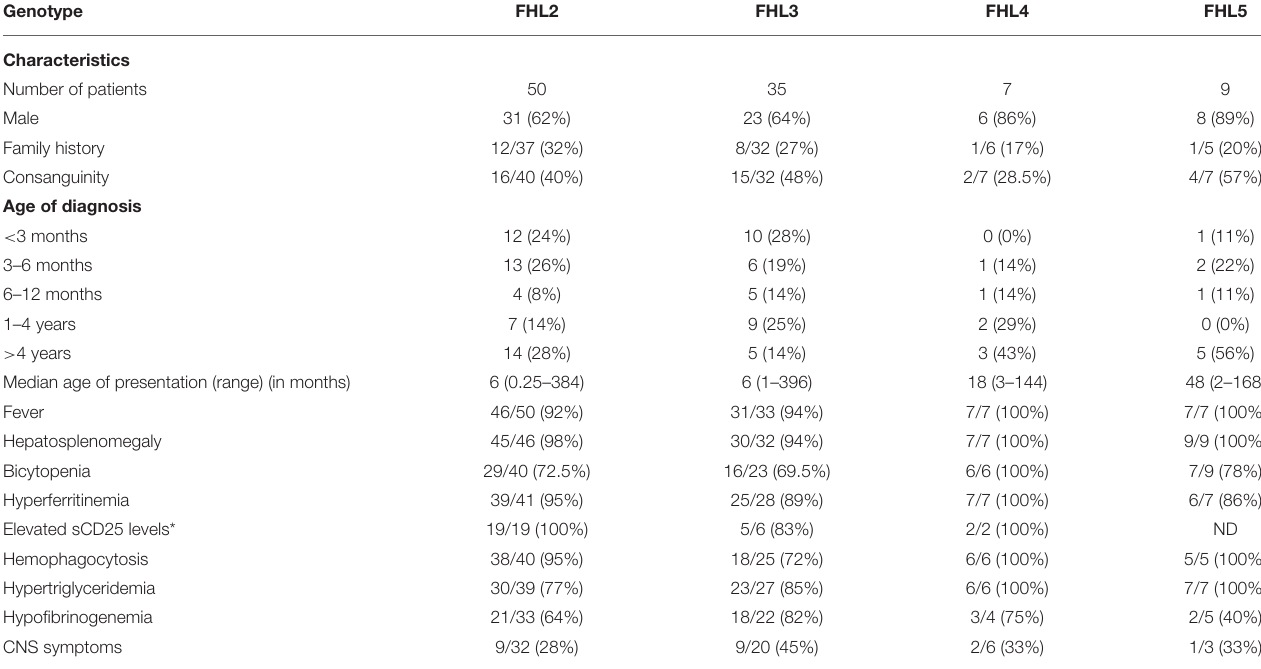
TABLE 1 | Comparison of patient characteristics in different groups of FHL patients. Genotype